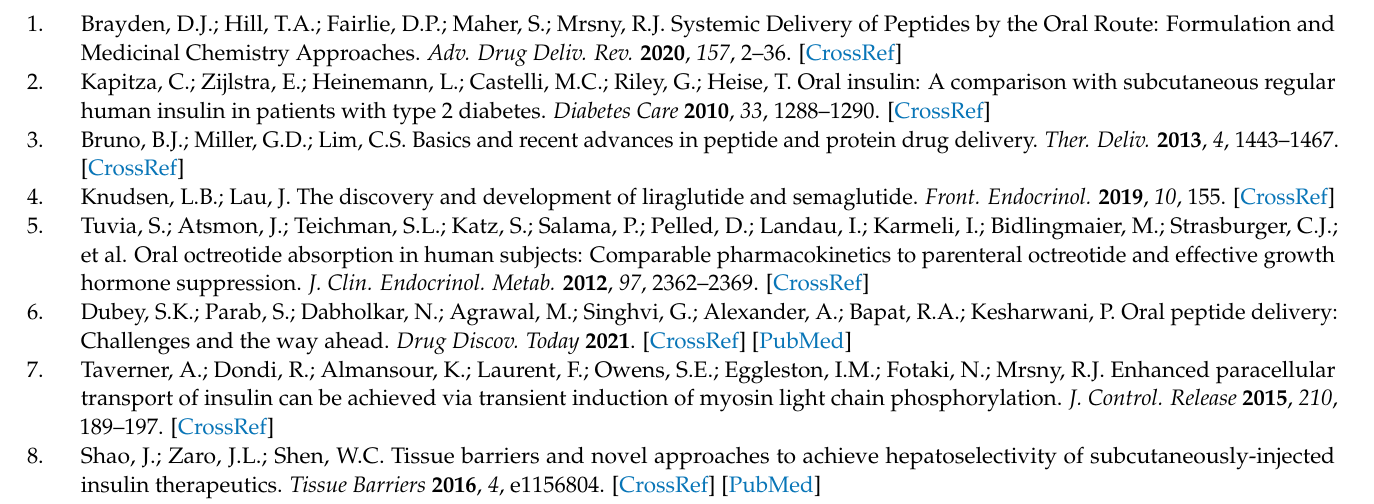
drug release. Table S2: The R2 adj and other parameters calculated for each type of release model. Figure S1: Swelling behaviour of insulin loaded